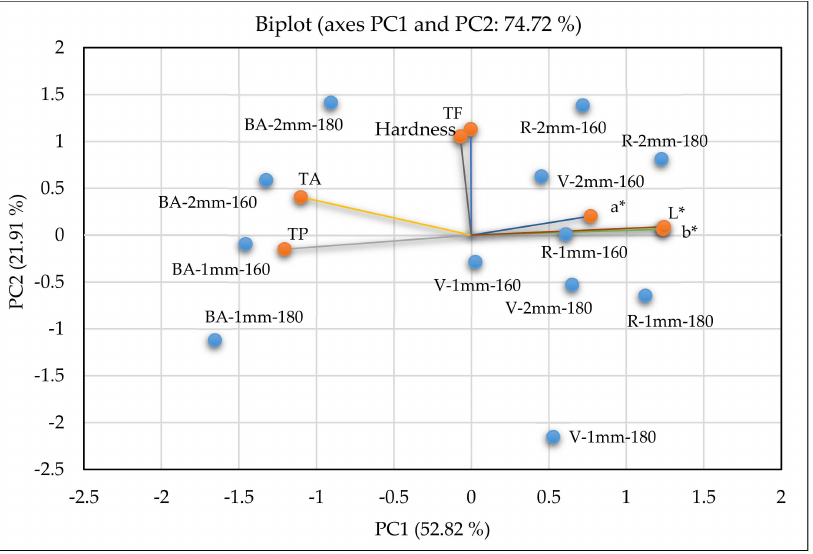
Figure 1. PCA for total phenolic content, total anthocyanins, total fat content, colour characteristics (L*, a* and b*) and hardness of the chips produced from coloured potato cultivars (BA-1mm-160-1 mm chips of Blaue Anneliese fried at 160 ◦ C, BA-1mm-180-1 mm chips of Blaue Anneliese fried at 180 ◦ C, BA-2mm-160-2 mm chips of Blaue Anneliese fried at 160 ◦ C, BA-2mm-180-2 mm chips of Blaue Anneliese fried at 180 ◦ C, V-1mm-160-1 mm chips of Valfi fried at 160 ◦ C, V-1mm-180-1 mm chips of Valfi fried at 180 ◦ C; V-2mm-160-2 mm chips of Valfi fried at 160 ◦ C, V-2mm-180-2 mm chips of Valfi fried at 180 ◦ C, R-1mm-160-1 mm chips of Rosemarie fried at 160 ◦ C, R-1mm-180-1 mm chips of Rosemarie fried at 180 ◦ C, R-2mm-160-2 mm chips of Rosemarie fried at 160 ◦ C, R-2mm-180-2 mm chips of Rosemarie fried at 180 ◦